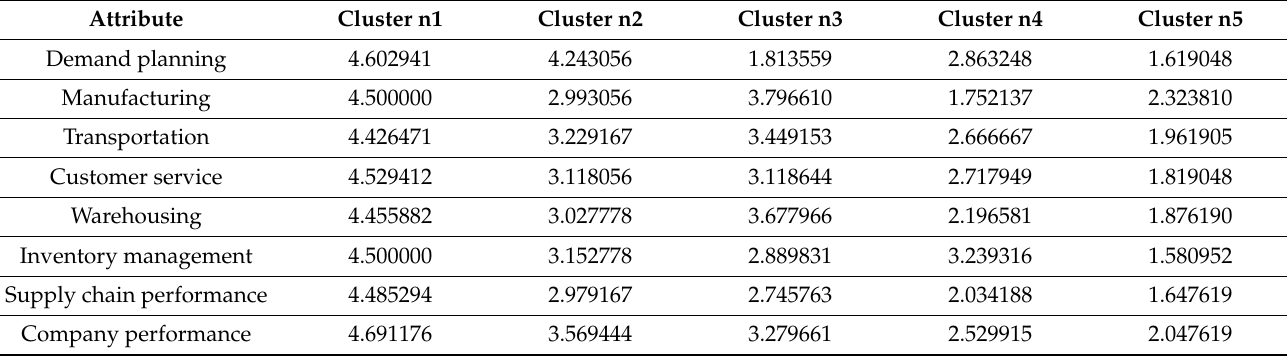
Table 7. The centroids of SOM clustering.